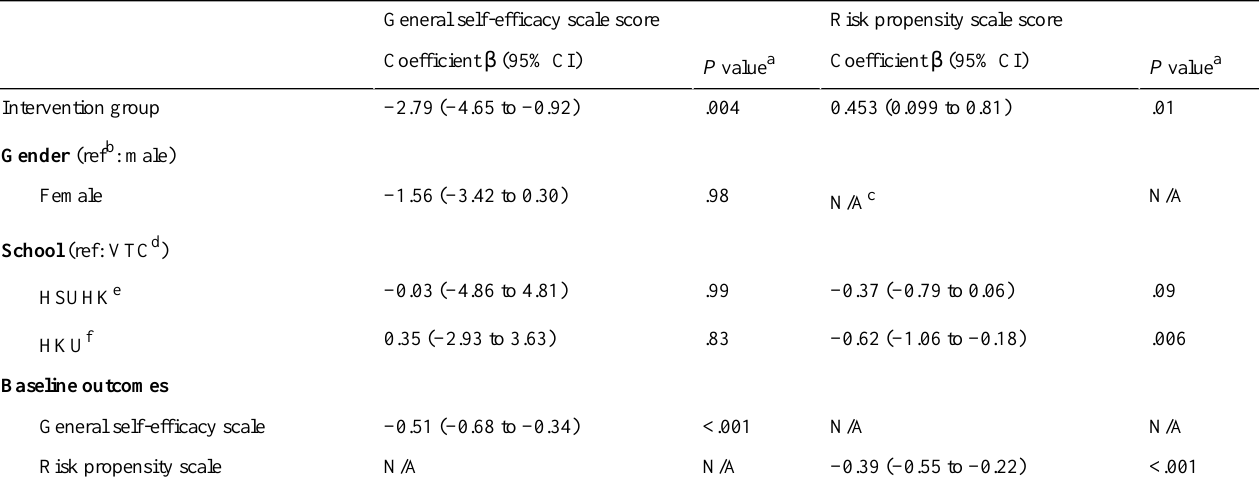
Table 6. Factors affecting the general self-efficacy scale and risk propensity scale scores using a multiple linear regression model.